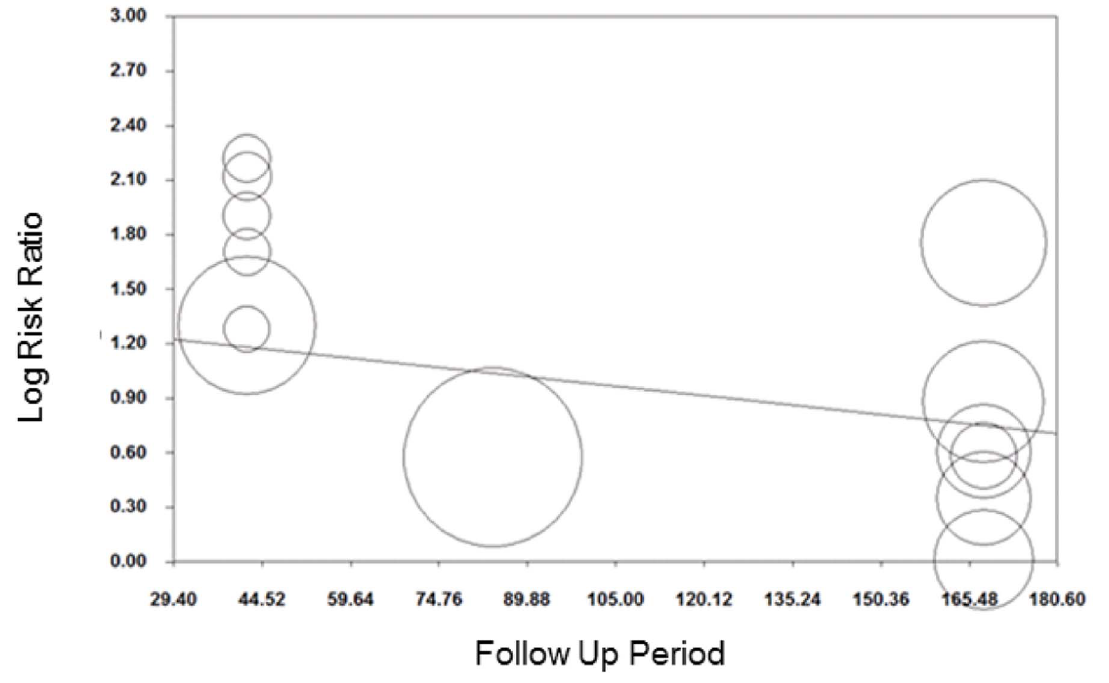
Figure 5. Meta-regression of incentive value on relative risk, smoking cessation (follow-up up , six months).